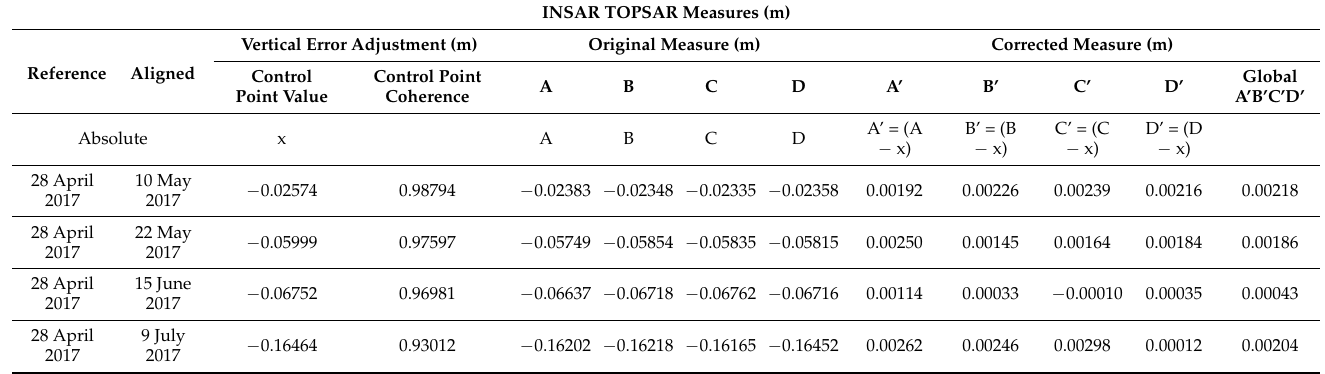
Table 5. Deformation measurements by Differential Interferometry over IW TopSAR images, with and without vertical adjustment using zero-deformation control points (very high coherence